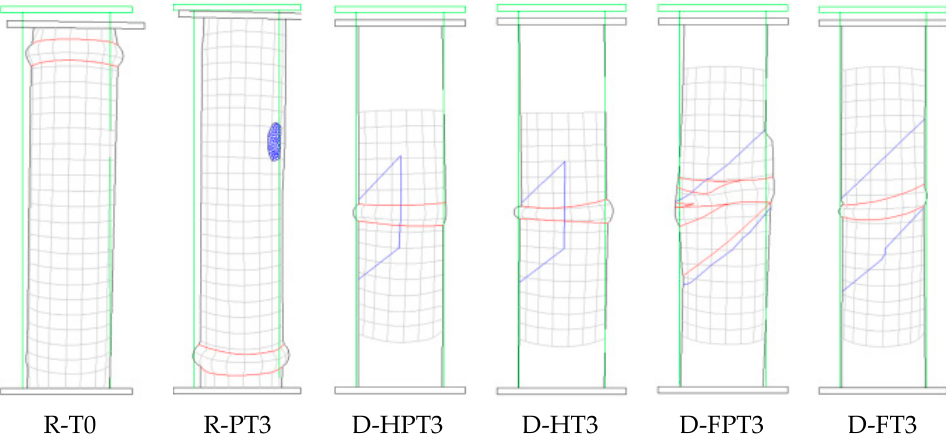
Figure 11. The specimens before and after the compressive loading tests [51].